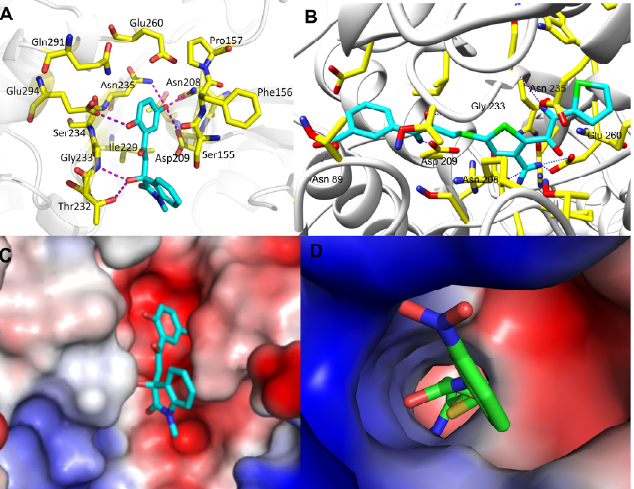
Figure 4. The binding mode analysis of hit compounds and HK-II. ( A ) 4244-3659 and protein interaction of the three-dimensional binding mode map. ( B ) K611-0094 and protein interaction of the three-dimensional binding mode map. ( C ) Electrostatic interaction between 4244-3659 and protein interaction map. ( D ) Electrostatic interaction between K611-0094 and protein interaction map.